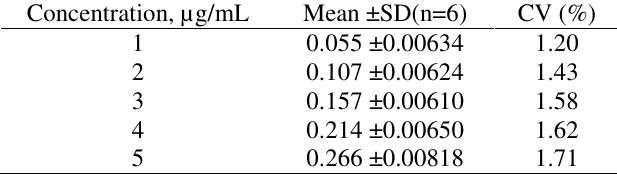
Table 2 . Results of least square regression analysis of UV methods for the estimation of